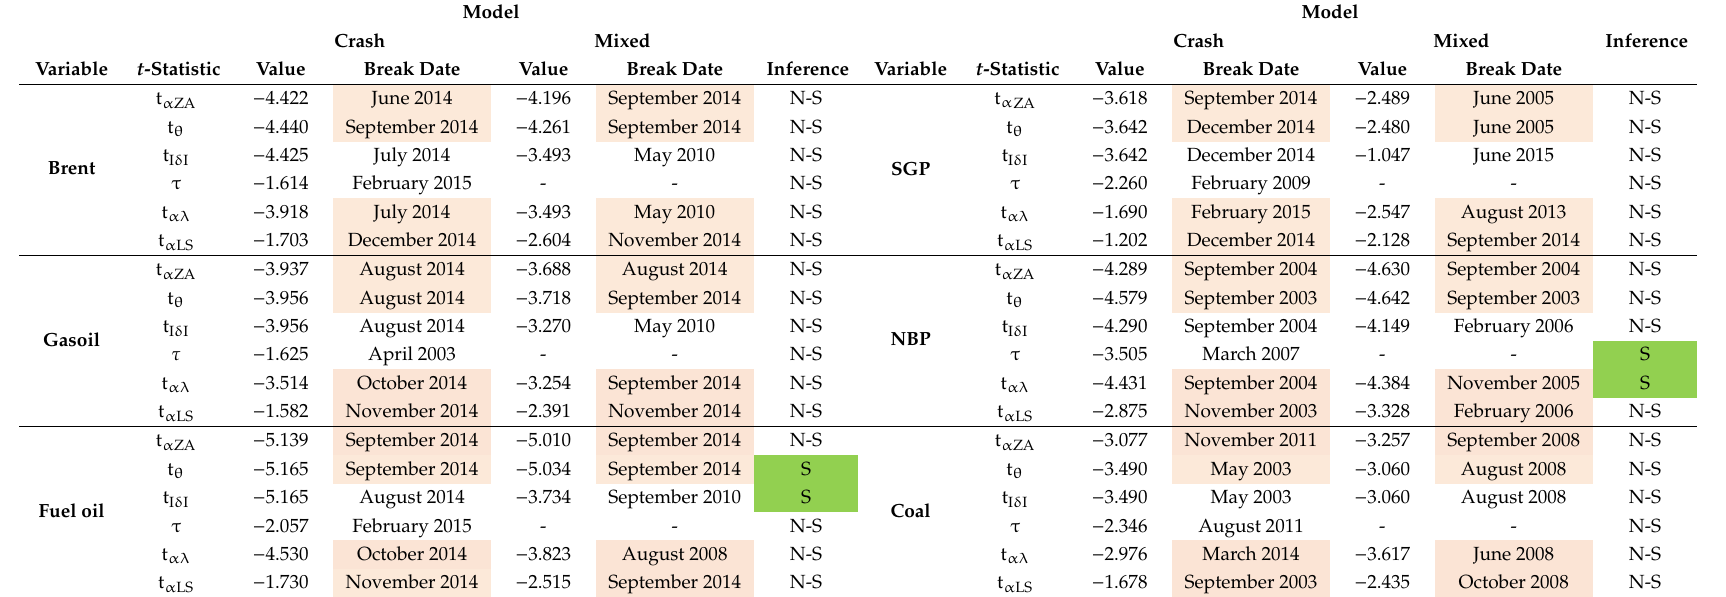
Table 3. One-break unit root test